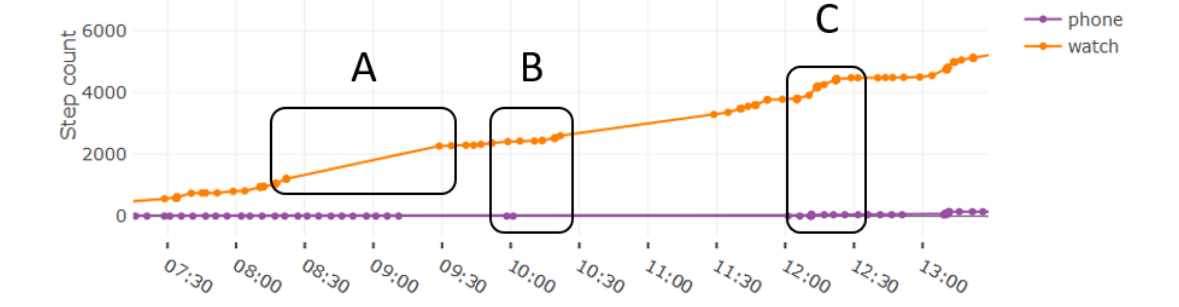
Figure 11. Error bars demonstrating the large difference between total daily step count between watch and phone for each available